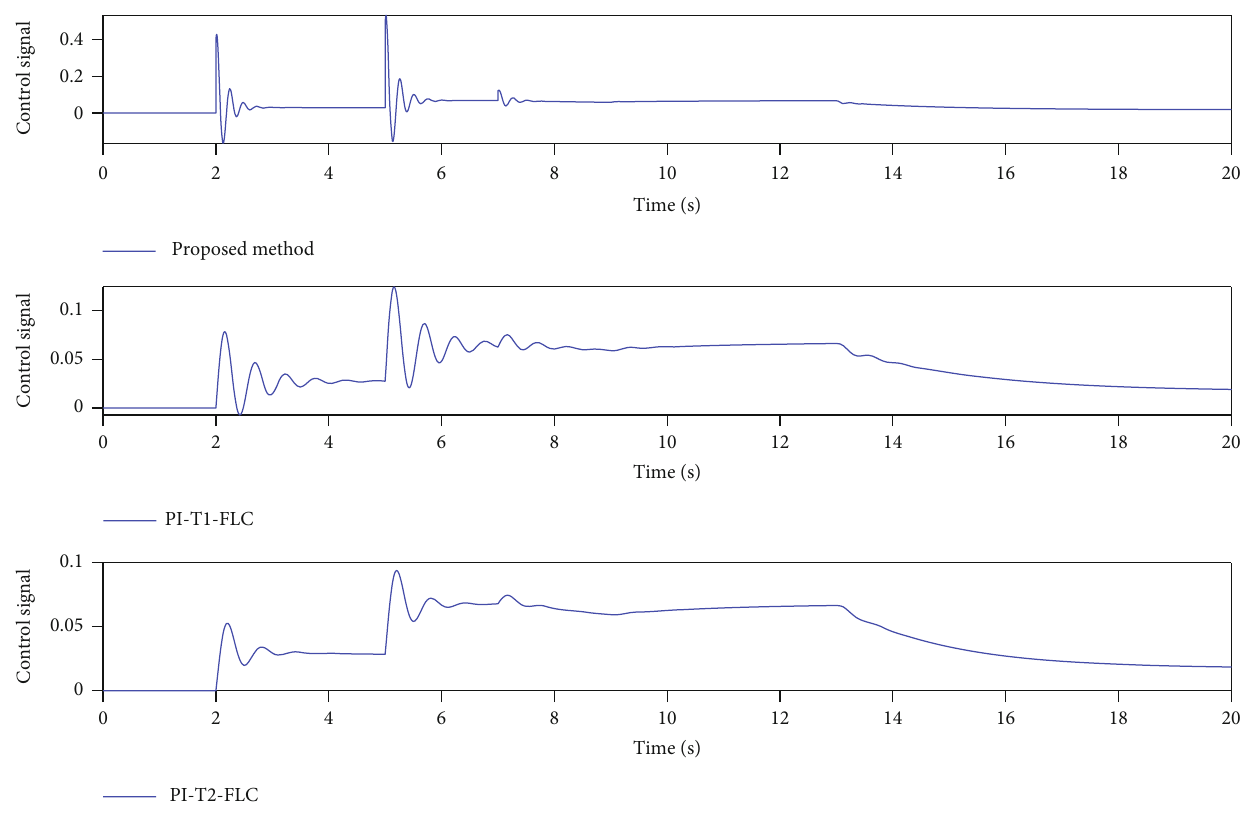
Figure 11: Scenario 3: control signals. Table 2: RMSE